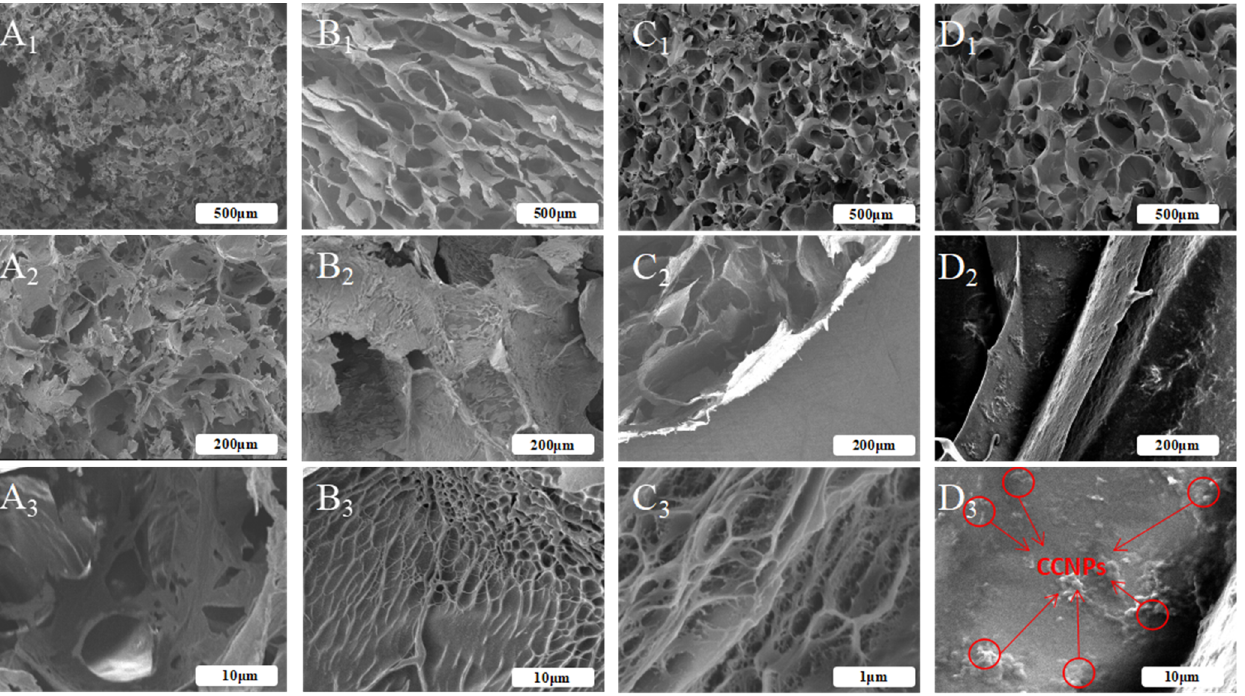
Figure 3. The cross section SEM images of the freeze-dried SF scaffold ( A 1 , A 2 , A 3 ), SF/HAMA ( B 1 , B 2 , B 3 ), HAMA ( C 1 , C 2 , C 3 ), and CCNPs-SF/HAMA freeze-dried hydrogels ( D 1 , D 2 , D 3 ).